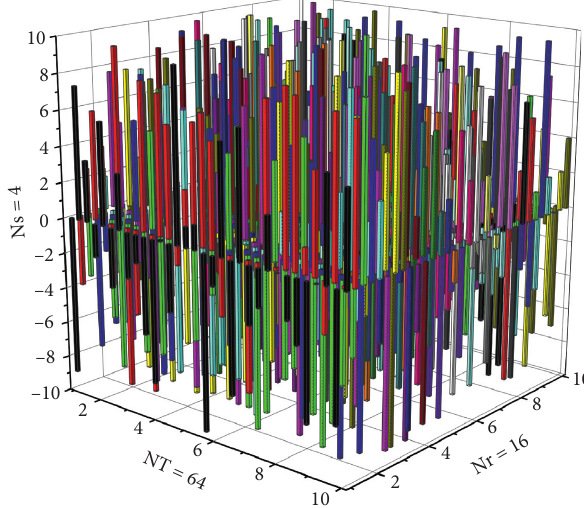
Figure 6: Spectral efficiency vs. RF link in millimetre-wave MIMO